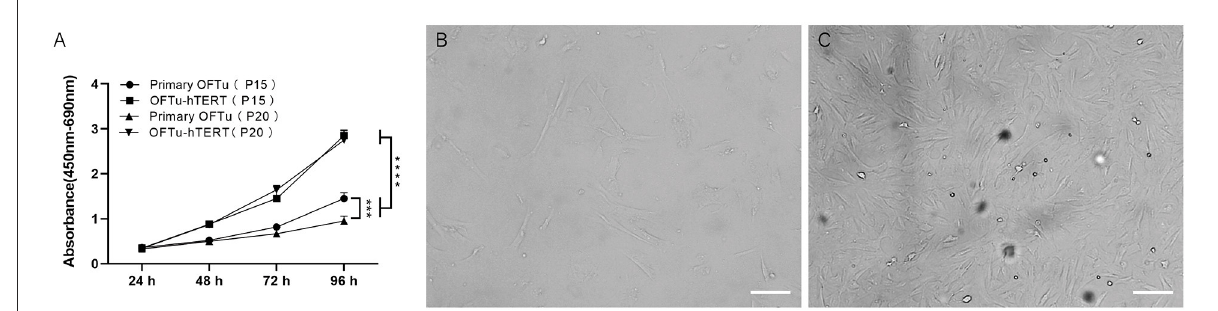
FIGURE2 Cell morphology and growth characteristics of immortalized OFTu cells. (A) Immortalized OFTu at 15th and 20th passages showed a significantly stronger capacity for proliferation than primary OFTu at 15th and 20th passages. Primary OFTu passage 30 (B) , immortalized OFTu passage 80 (C) under phase contrast microscope. Scale bar = 100 µ m. Data are expressed as the means ± SD of the results of 3 separate experiments and analyzed by one-way analysis of variance (ANOVA) with uncorrelated Fisher LSD multiple comparisons test with GraphPad